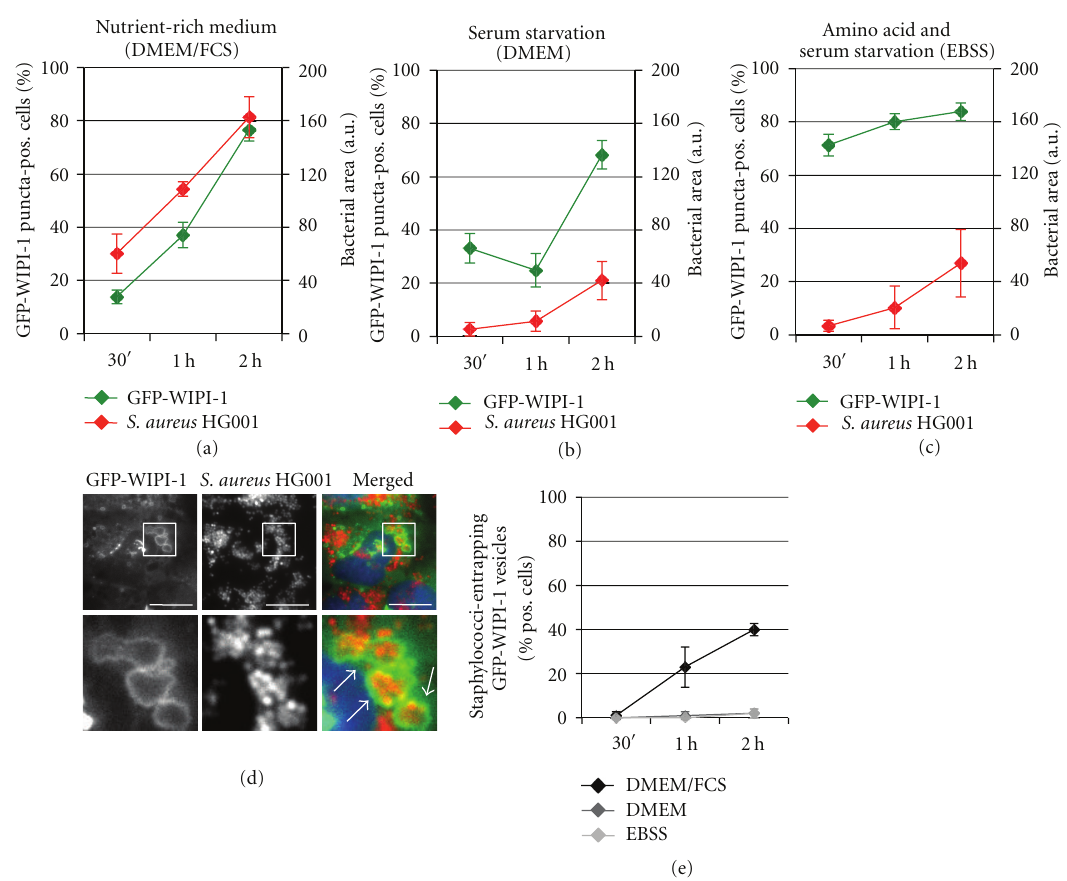
Figure 5: Pathogenic S. aureus HG001 induces GFP-WIPI-1 puncta formation and becomes entrapped in GFP-WIPI-1 positive autophagosome-like vesicles. According to Figure 4, GFP-WIPI-1 U2OS cells were infected with mCherry-expressing S. aureus HG001 in DMEM/FCS (a), DMEM (b), and EBSS (c), and up to 2000 individual cells were analyzed. Images (2h, DMEM/FCS) are shown (d). Scale bars: 20 μ m. The number of cells displaying GFP-WIPI-1 positive autophagosomal-like vesicles entrapping S. aureus HG001 was determined (e) ± SD ( n = 2, each in